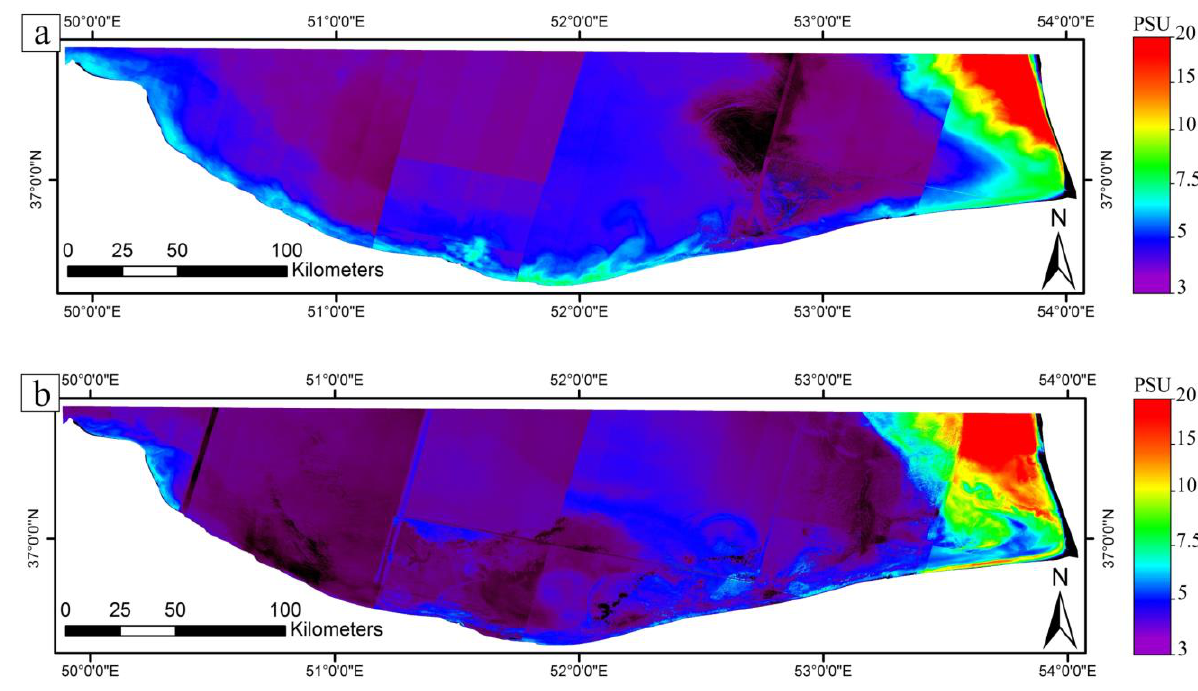
Figure 5 . The sea surface salinity of the Caspian Sea obtained from Landsat 9 OLI data of pre-monsoon (a) and post-monsoon (b), summer 2022.